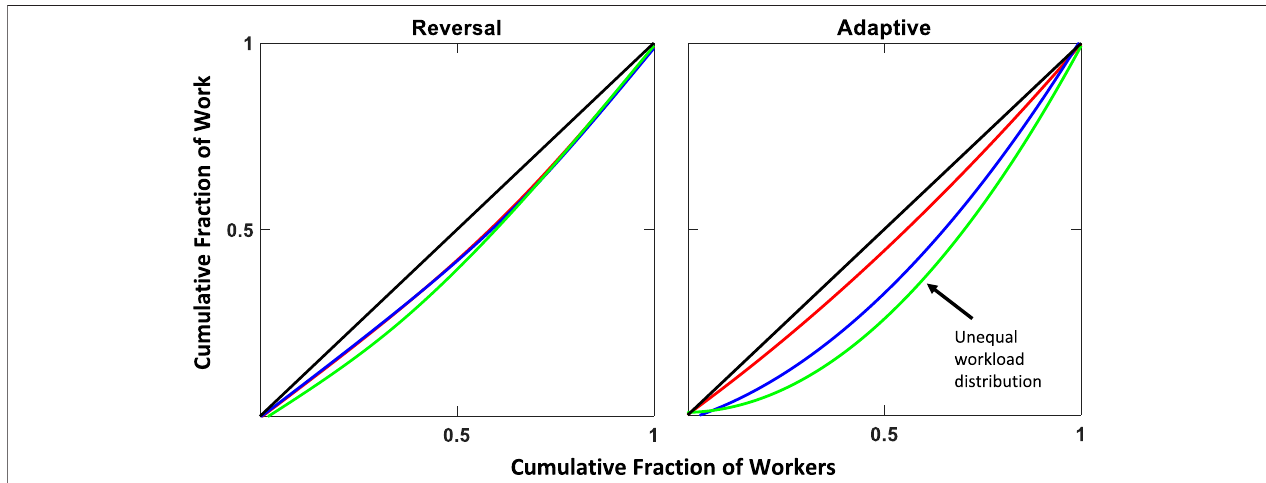
FIGURE 9 | Lorenz curves of robot workload distribution for 1-h “ epochs ” of 3-h experiment. The curves represent: 1 h duration (red), 2 h duration (blue), and 3 h duration(green).Blacksolidlinerepresentsthelineofequality.Cumulativefraction ofworkisthenumberoftripstherobotstookintothetunnelinanattempt toexcavate pellets.In Reversalprotocol, allrobots aremostlyinsidethetunnel,eithergoingintoexcavate pelletsorgoingout todump or “ give-up ” andre-enterthetunnel. Adaptive rule on the other hand leads some robots to rest and become less active over time.